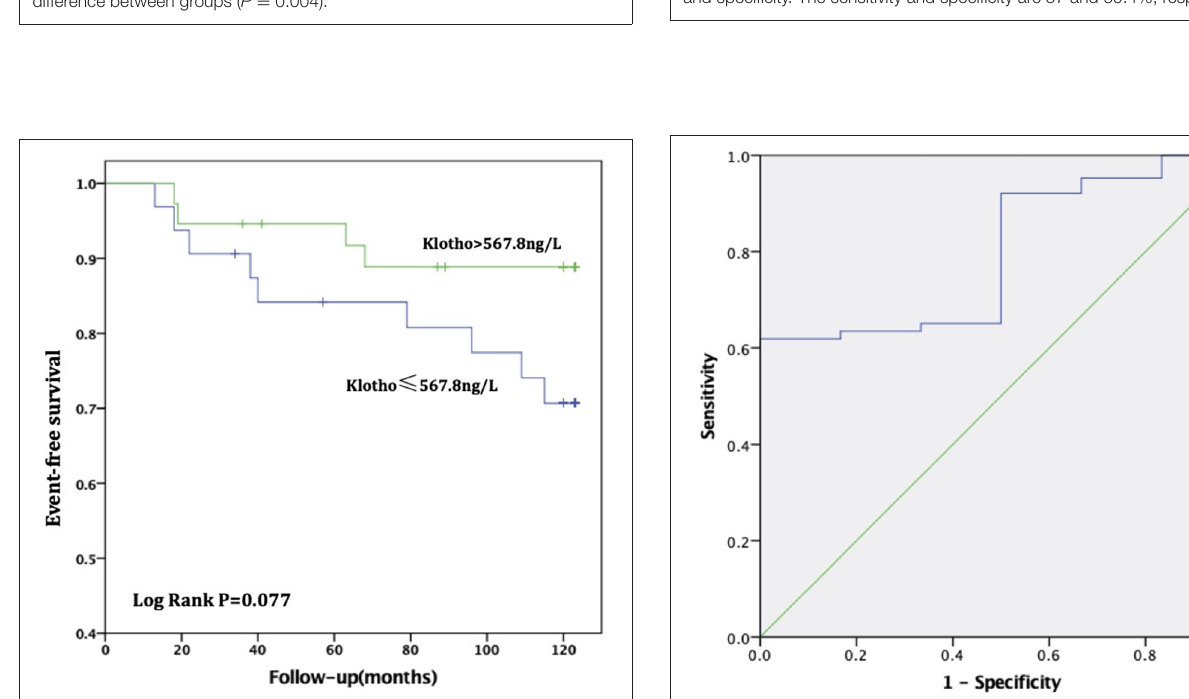
FIGURE 6 | The role of soluble Klotho in predicting the CVD mortality in MHD patients. The receiver operating characteristic curve illustrates soluble Klotho. Areas under the curves are 0.634 (95% CI 0.528–0.740, P = 0.019) for the soluble Klotho. A cut off valuable of 566.52 pg/ml yielded to good sensitivity and specificity. The sensitivity and specificity are 57 and 69.4%, respectively.